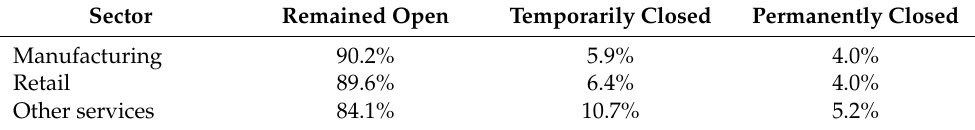
Table 2. Percentage of companies that remained open or were temporarily or permanently closed.